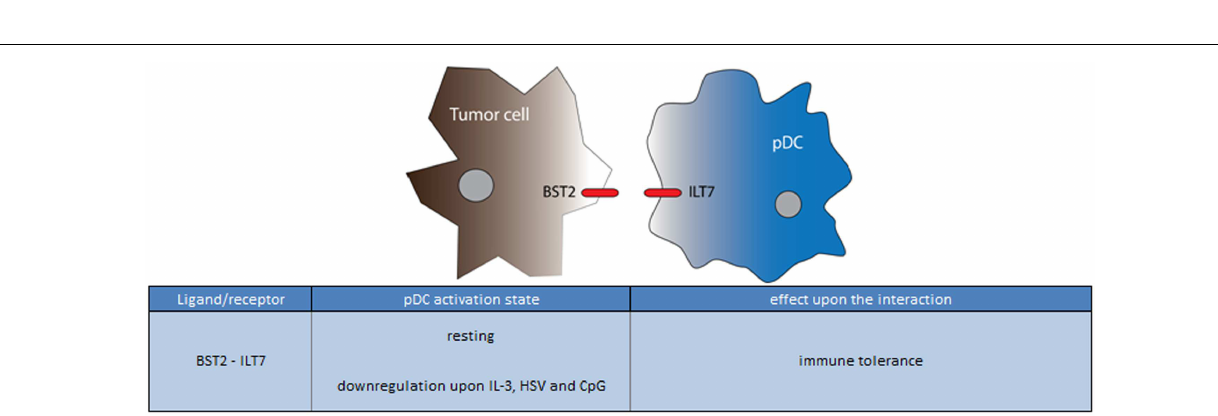
TLR-7 and 9-induced IFN- α and TNF- α production (163,